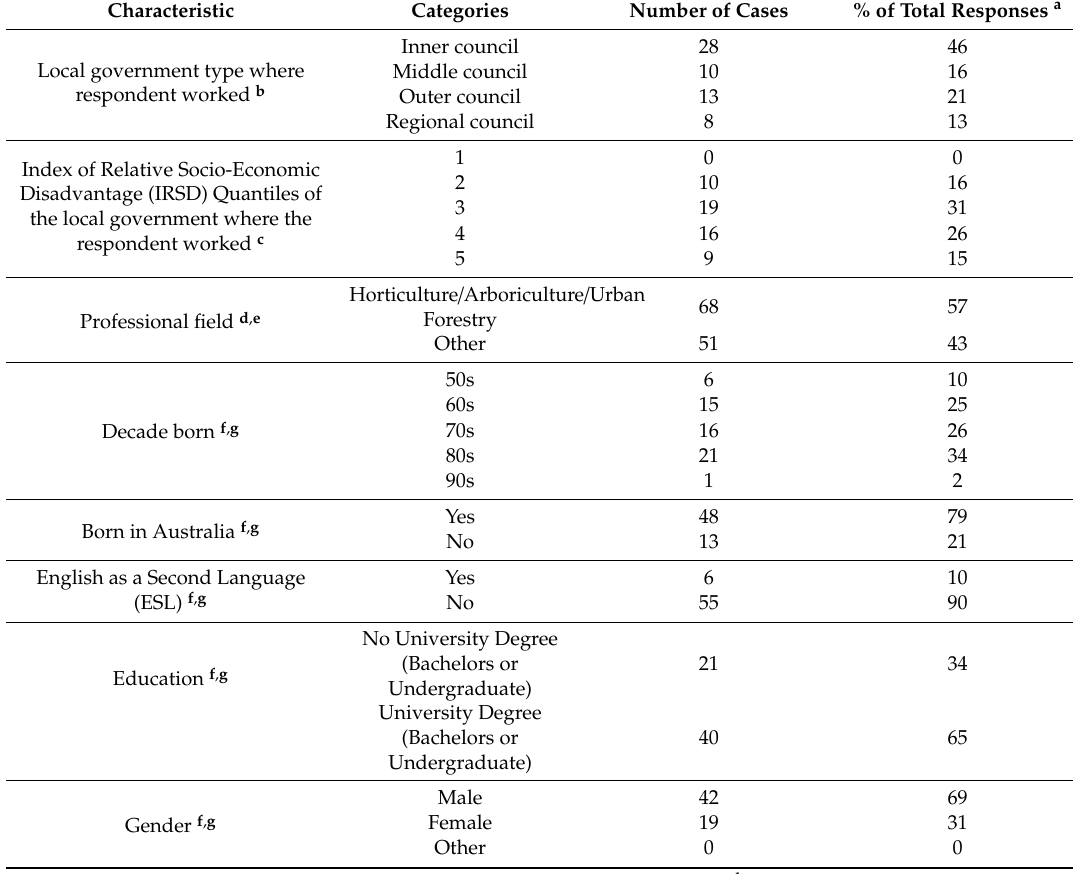
Table 3. Characteristics of the respondents of the online survey ( n =